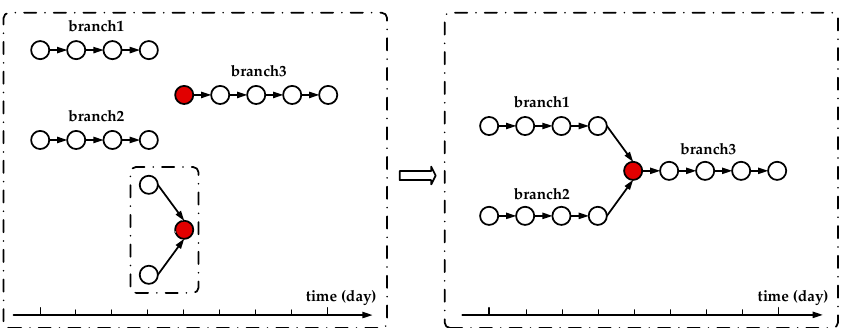
Figure 9. A diagram of constructing a nonlinear Eddy-DAG . The branches with a merging relationship are taken as an example, where the merging relationship among eddy branches (branch1, branch2 and branch3) is established by the segment, taking the eddies on the last day of the lives of branch1 and branch2 as the sources and the eddy on the first day of the life of branch3 as the sink.